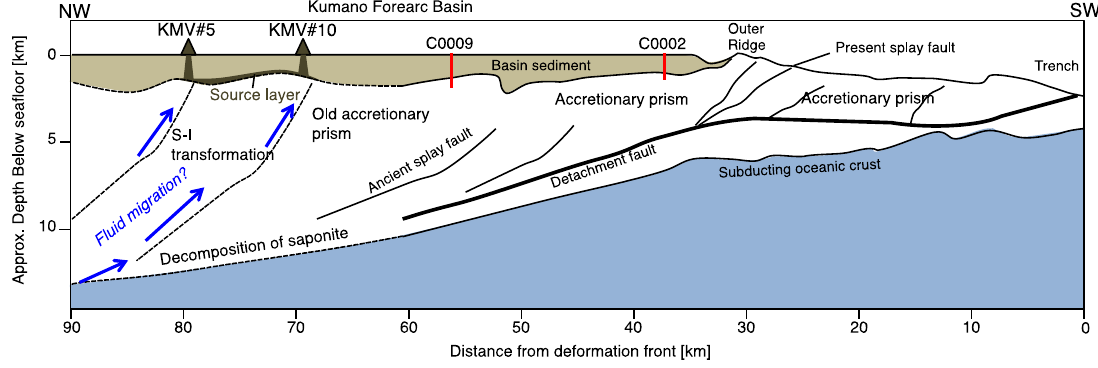
Figure 8. Sectional view of the Kumano forearc basin showing the origin of mud volcano sediments (source layer) and fluid migration from the old accretionary prism. Red bars indicate the locations of IODP Sites C0002 and C0009.